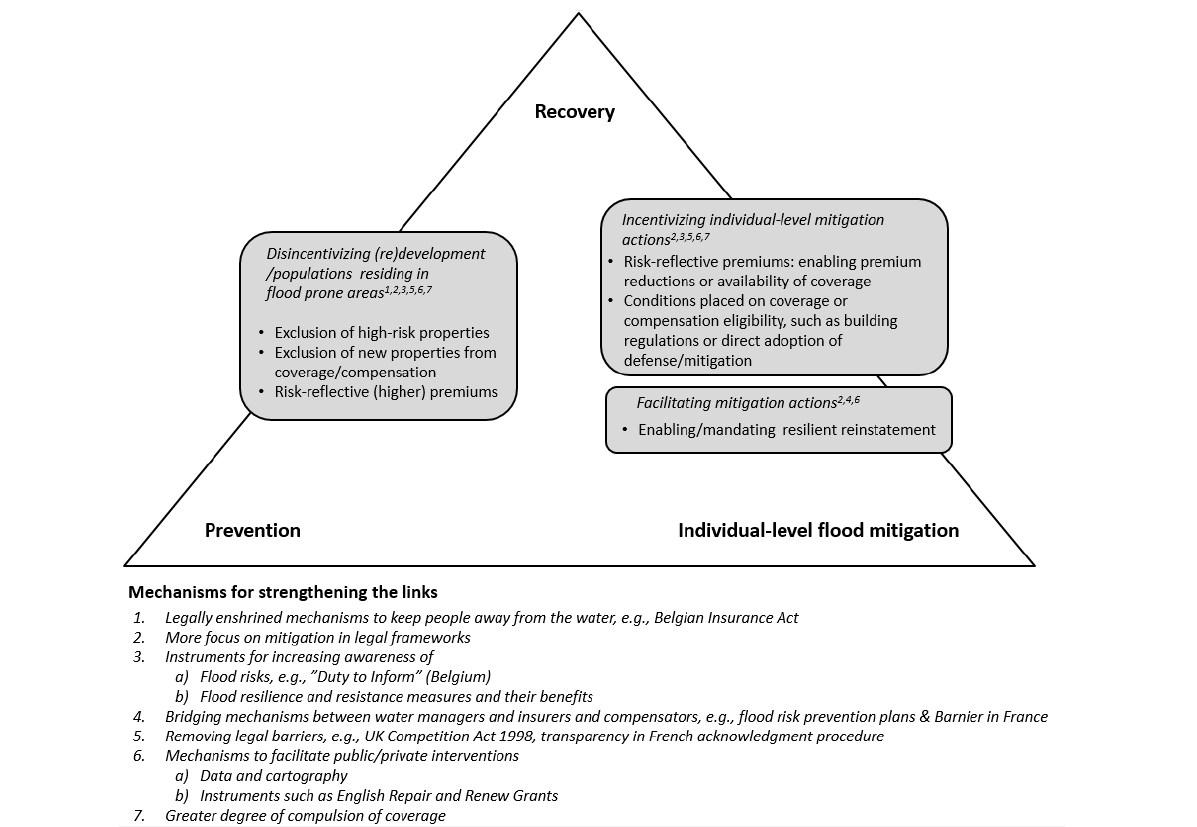
Fig. 2 . Measures and instruments to strengthen the links between